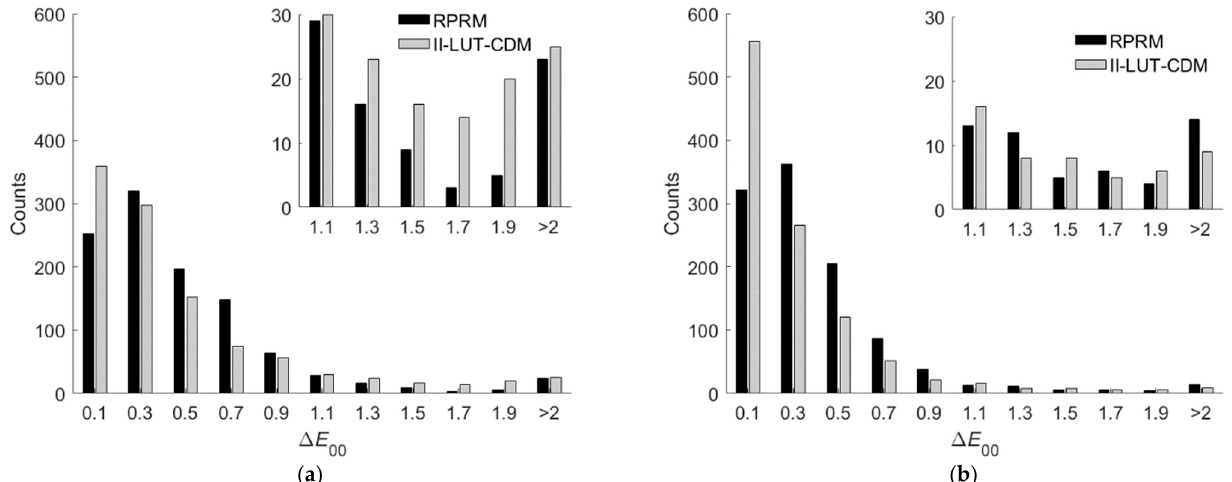
Figure 14. The Δ E 00 histograms for the 1066 test samples using the ( a ) D5100 camera and ( b ) RGBF camera. The corresponding camera device models are shown in figures. The insets show enlarged parts.